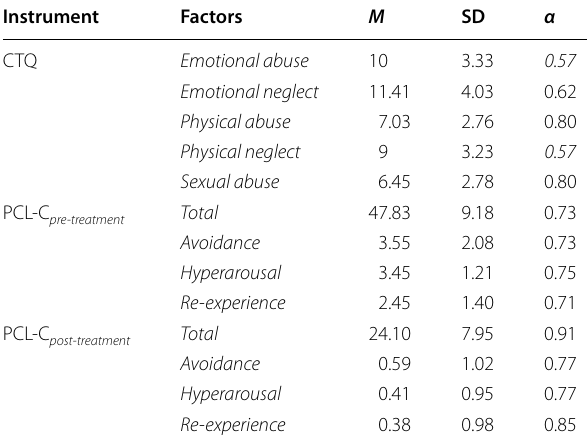
Table 3 Cronbach’s alpha internal consistency reliabilities